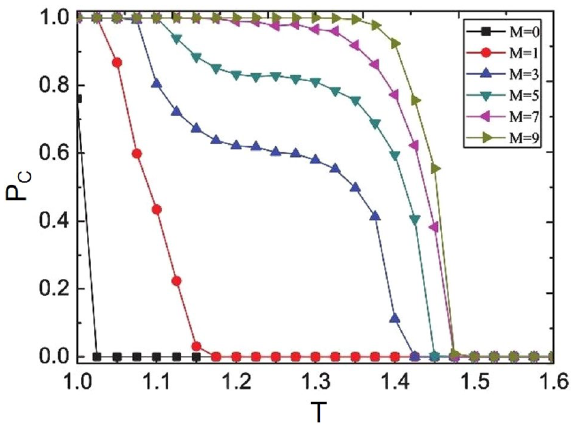
Figure 1. When β =0.5, K = 0.1 , the evolution of cooperation rate with defect temptation T under different M ( M = 0, 1, 3, 5, 7, 9